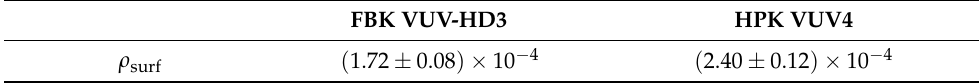
Figure 5. Pictorial representation of how the quantity ρ surf is calculated for the HPK VUV4 MPPC (top) and FBK VUV-HD3 (bottom) SiPM combining the information of Figures 3 and 4. R k , with k = { 1,2,3 } are selected regions where the photon count is measured. See text for more details. Table 4. Values of ρ surf for the FBK VUV-HD3 and HPK VUV4